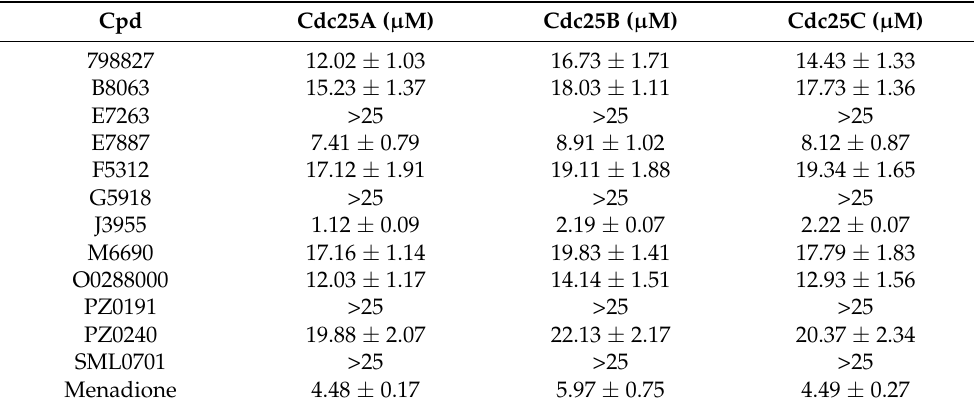
Table 3. IC 50 values of the selected compounds for the inhibition of Cdc25 A, B, and C phosphatases.